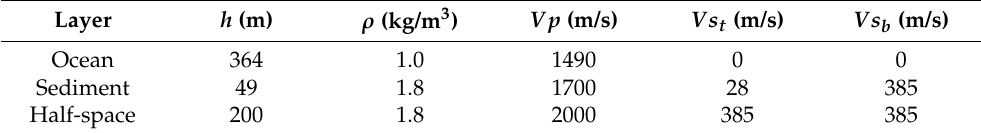
Table 7. LC model for Case 2.